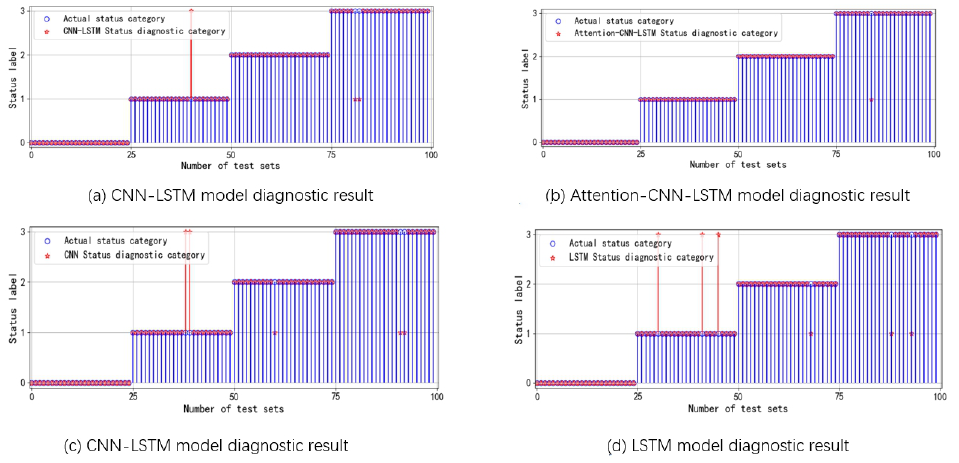
Figure 13. Four model status diagnostic results.